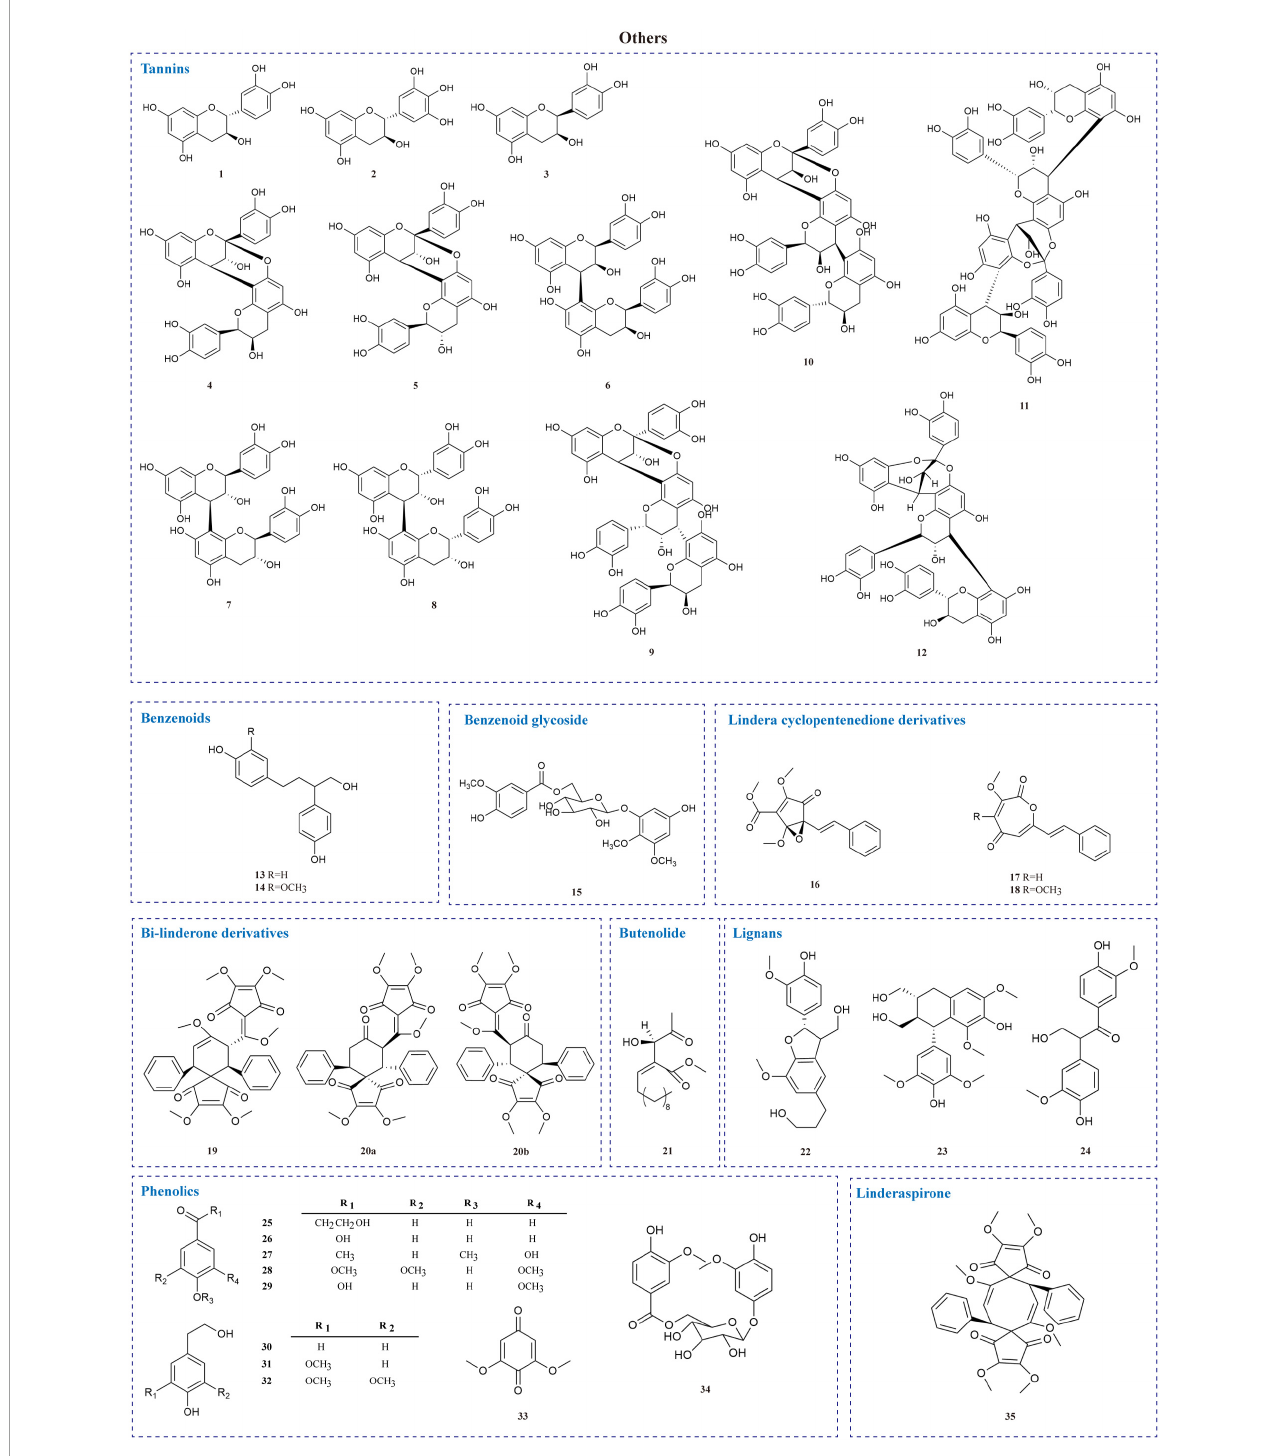
FIGURE4 Chemical structures of other components in L. aggregata.